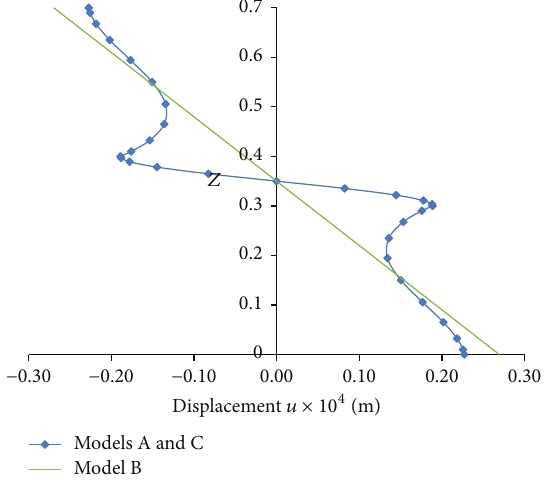
Figure 9: Axial displacement variation along 𝑧 -axis at step ( 𝑥 = 2 m).